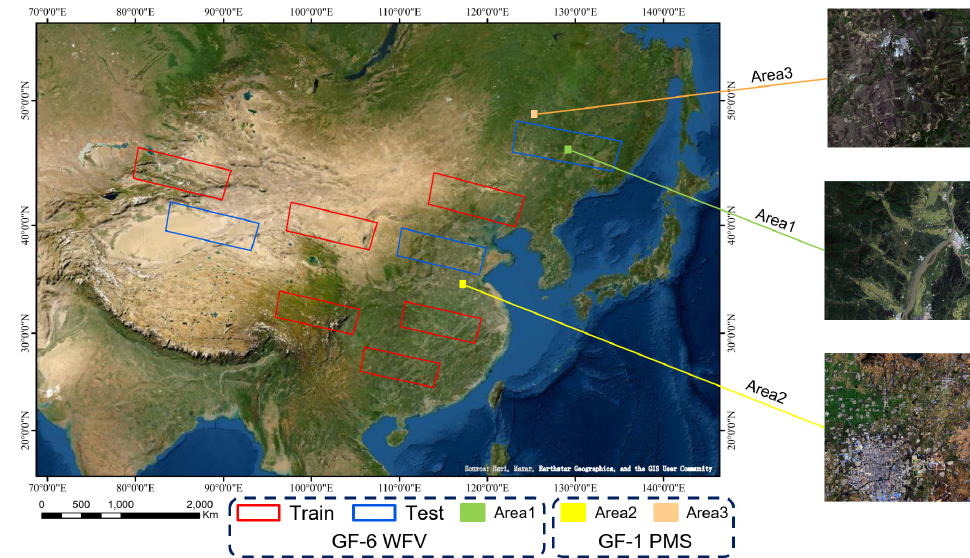
Figure 5. Image regions used for training and testing from China Center For Resources Satellite Data and Application website [40].